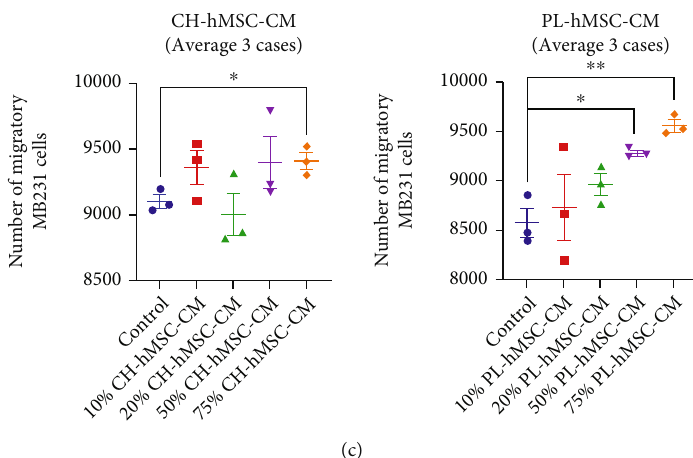
Figure 5: The e ff ect of soluble factors on the migration of human breast cancer MDA-MB231 cells. (a) Representative micrographs of migratory MDA-MB231 cells induced by 10%, 25%, 50%, and 75% conditioned medium derived from CH-hMSCs (CH-CM) PL-hMSCs (PL-CM) determined by the transwell migration assay. CH-CMs were prepared from 3 CH-hMSCs (CH9, CH15, and CH16), and PL- CMs were prepared from 3 PL-hMSCs (PL11, PL14, and PL17). MDA-MB231 cells induced by DMEM medium +30% FBS served as controls. (b) Graphs show the number of migratory MDA-MB231 cells induced by 10%, 25%, 50%, and 75% conditioned media derived from CH-CM and PL-CM determined by transwell migration assay. Data are presented as mean ± SEM of three experiments. CH-CMs were prepared from 3 CH-hMSCs (CH9, CH15, and CH16), and PL-CMs were prepared from 3 PL-hMSCs (PL11, PL14, and PL17). show the number of migratory MDA-MB231 cells induced by 10%, 25%, 50%, and 75% conditioned media derived from CH-hMSC-CM (average of CH9, CH15, and CH16) and PL-hMSC-CM (average of PL11, PL14, and PL17). Data are presented as mean ± SEM of